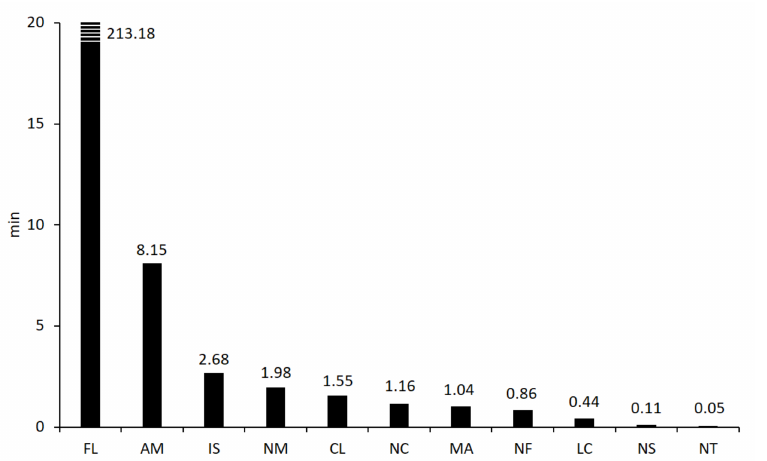
Figure 3. Irradiation time (min) causing a 10% degradation (t 10 ) of the hydroalcoholic DHP solutions in quartz containers, under a radiant power corresponding to a dose energy of 21 kJ (min m 2 ) − 1